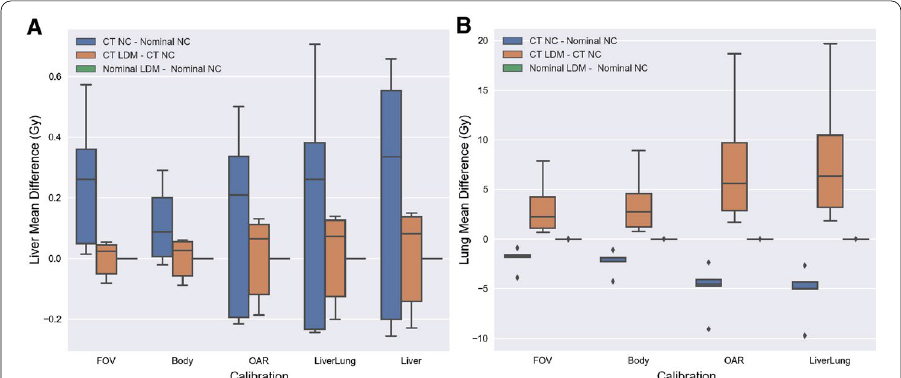
Fig. 6 A boxplot of the mean dose differences between the CT and nominal implementations of the NC and local deposition methods (LDM) for the ( A) liver and ( B) lung. The legend summarizes the calculation